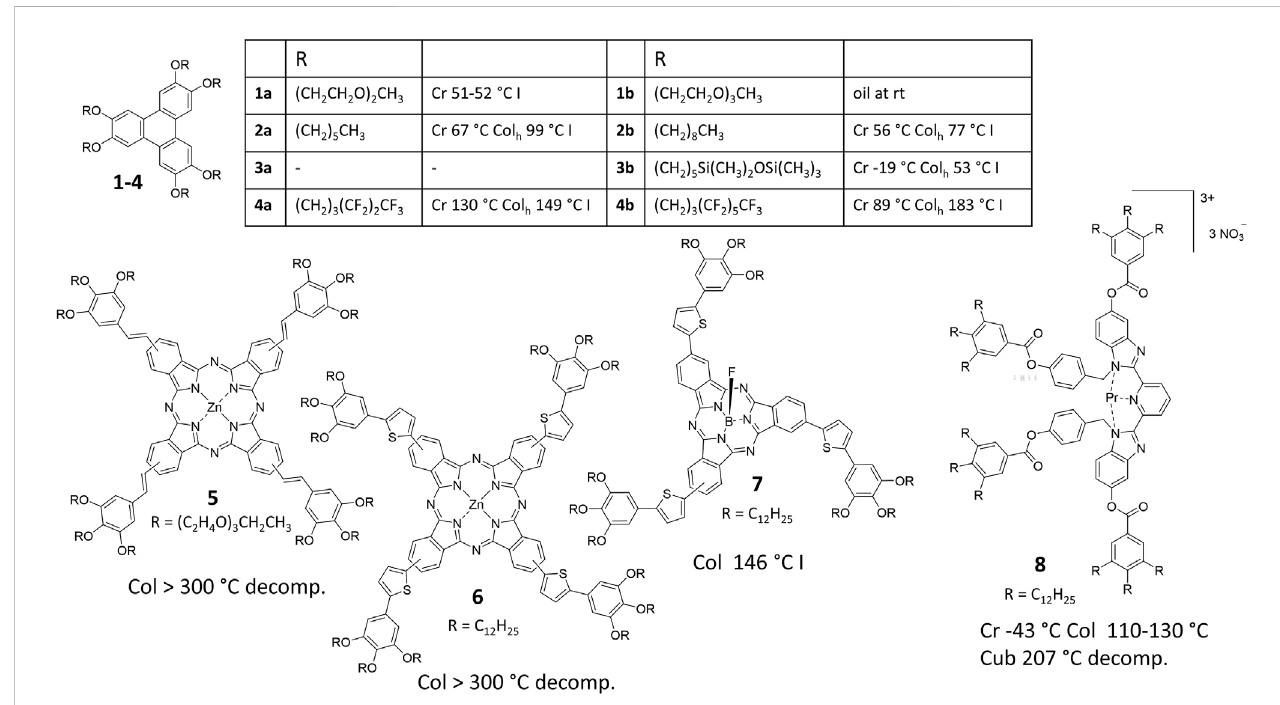
FIGURE 1 Transition temperature control by cohesive energy density difference (CED) and the number of peripheral